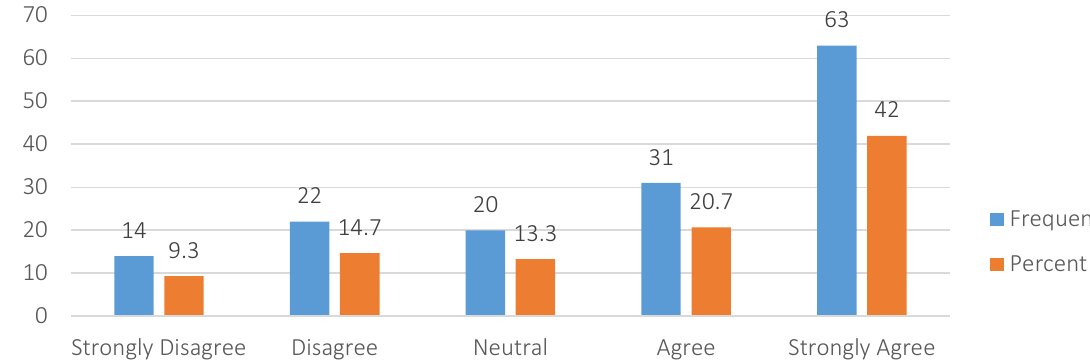
Figure 5. Technology adoption influences the adoption of